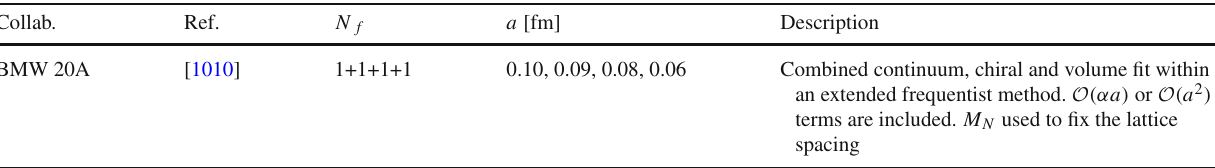
Table 194 Continuum extrapolations/estimation of lattice artifacts in determinations of σ π N and σ s from the Feynman–Hellmann method Collab.